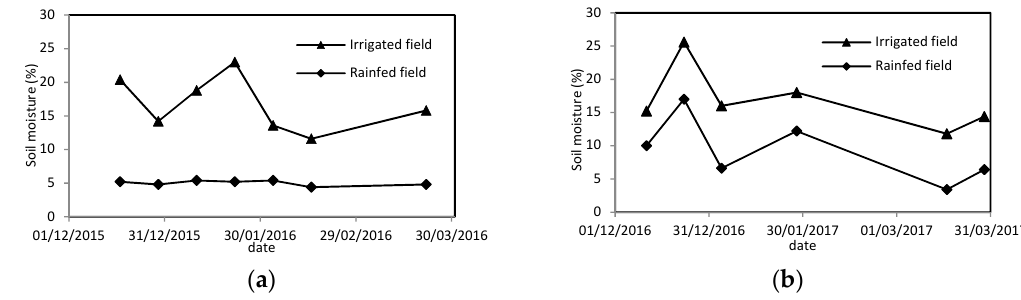
Figure 10. Temporal time series of remotely sensed soil moisture estimations, ( a ) 2015–2016; ( b ) 2016–2017.